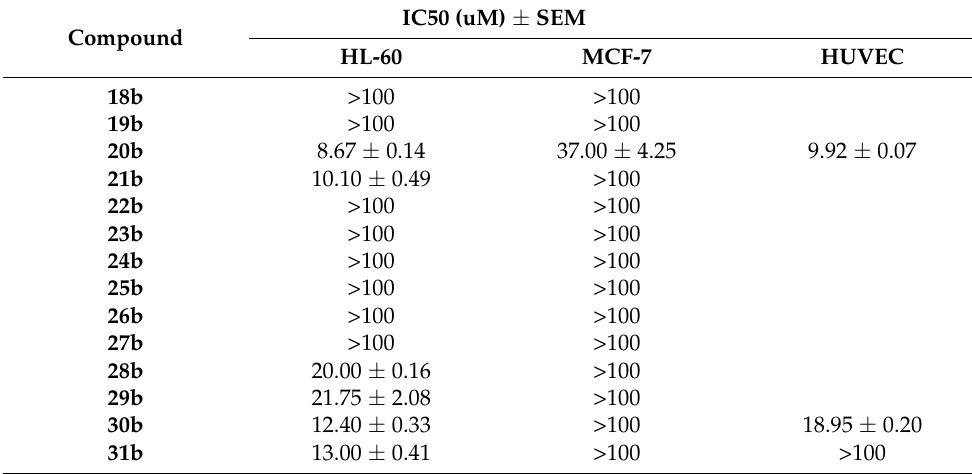
Table 3. The antiproliferative activity of compounds 18b – 31b .